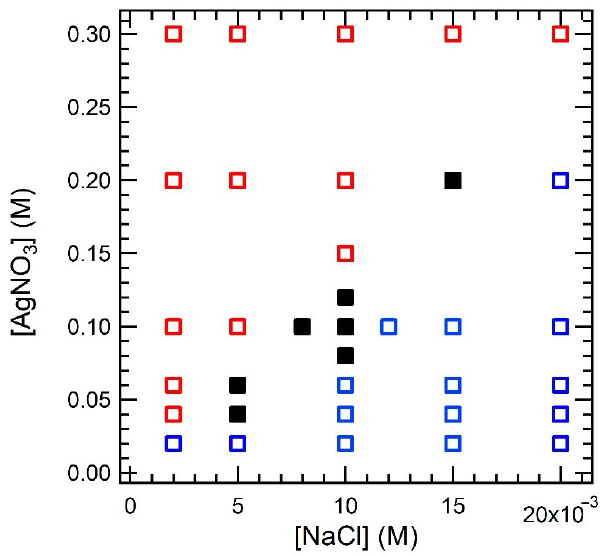
Figure 3. Phase diagram of the precipitation mode of AgCl as a function of [NaCl] and [AgNO 3 ]. Red open square: continuous precipitation with a gradual edge, black closed square: periodic precipitation, and blue open square: continuous precipitation with a sharp edge.